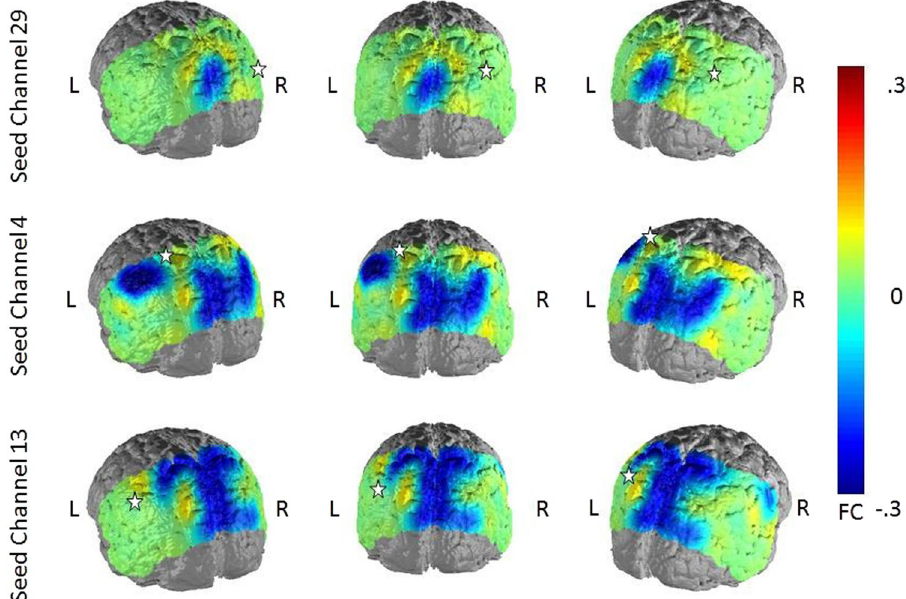
Figure 5. Differences between “depressed low trait-ruminators” and “depressed high trait-ruminators”. Cold colors indicate lower FC in high-ruminators compared to low-ruminators.